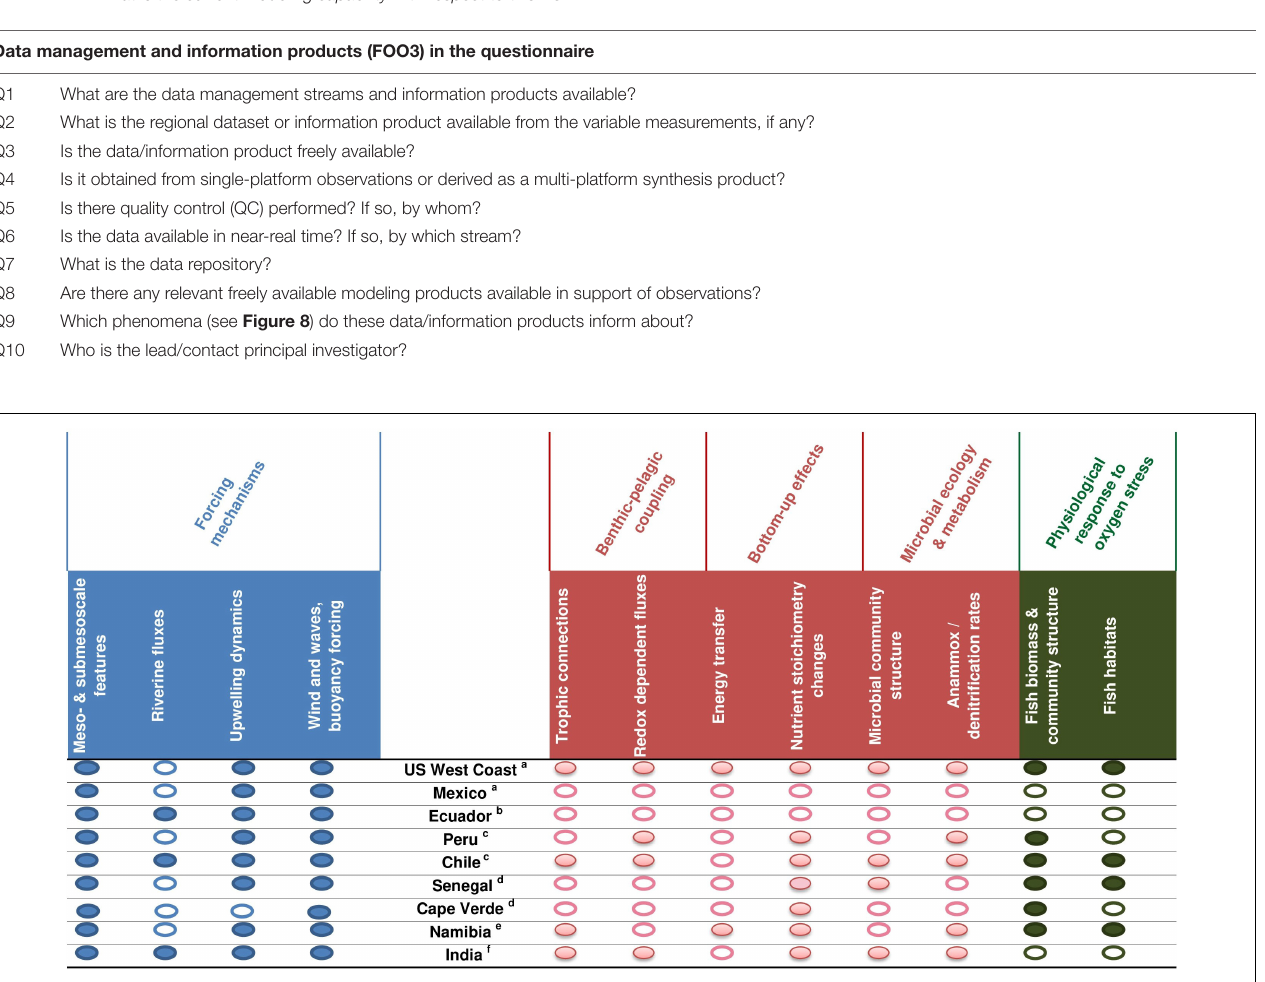
Frontiers in Marine Science |